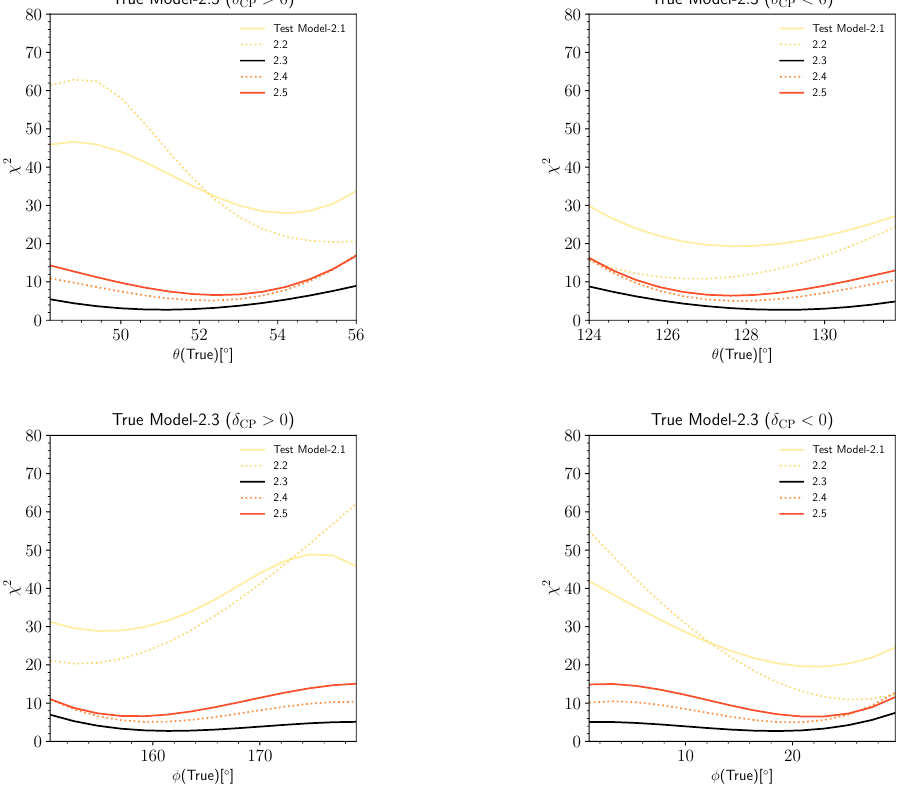
Figure 6 . Comparison among the (cid:12)ve allowed two-parameter models as test models for ESSnuSB using priors in the cases the model parameters (cid:30) (upper row) and (cid:18) (lower row) are minimized and corresponding to the (cid:12)rst (left column) and the second (right column) best-(cid:12)t points in table 8 for Model 2.3 as the true model. For description of each panel, see (cid:12)gure